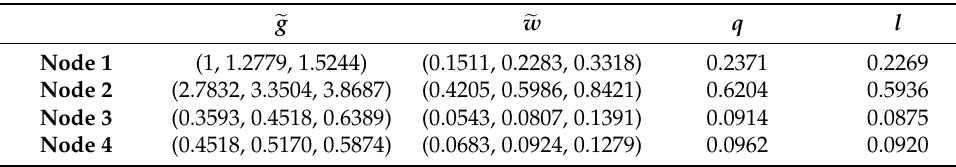
Table A7. Geometric mean ( (cid:101) g ) and weights ( (cid:101) w , q , l ) for distance criterion.